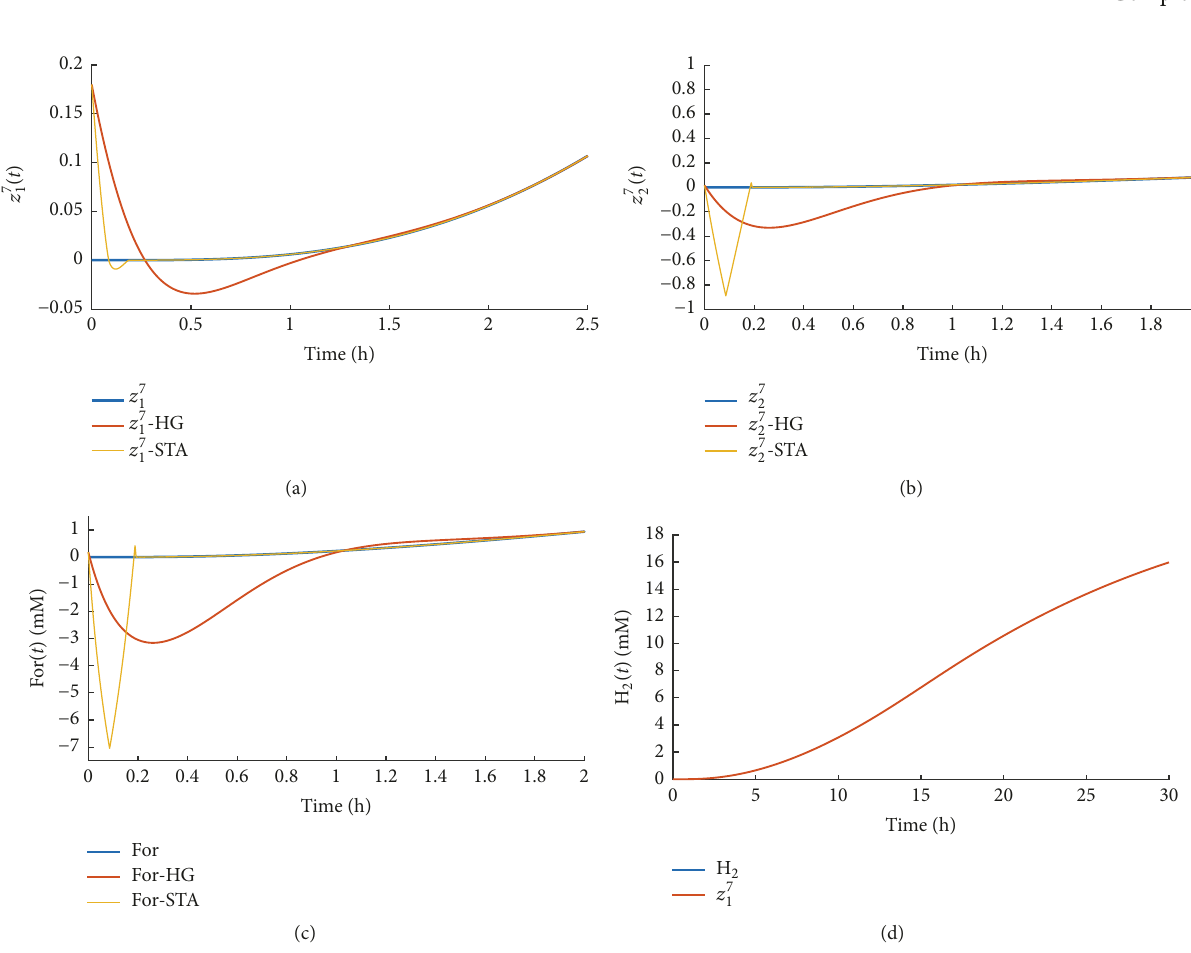
Figure 7: Detailed simultaneous visualization for the states of the transformed coordinates in the seventh subsystem, the corresponding high-gain observer, and the STA-based estimator: (a) 𝑧 7 1 and (b) 𝑧 7 2 during the first 5 hours. (c) and (d) depict the detailed variation of the concentrations for the compounds (c) For and (d) H 2 as well as their estimates produced by the inverse transformation applied to both the high-gain and the STA-based observer during the first 5